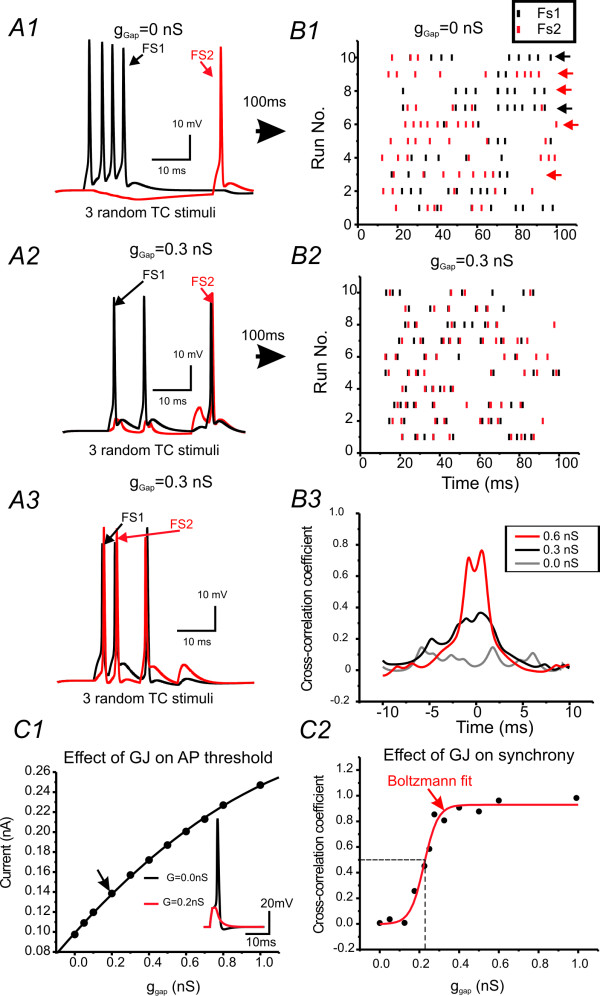
Roles of EPJPs in synchronizing 'whisking-like' TC responses in simulated networks. A) Membrane responses in a pair of FS cells induced by three TC inputs with variable latency to each cell. B1&2) Raster plot of a similar experiment as A1 showing the timing of spikes induced by asynchronous TC impulses in the two model FS cells without EPJP (B1) or with EPJP (0.3 nS, B2). Black and red arrows: FS cells 1 or 2 fire separately to the TC stimuli. B3) Cross-correlation analysis for evoked responses in the two model FS cells with different coupling strength (0-0.6 nS). C1) Effects of EPJP conductance on the spike initiation in model FS cells. C2) The relationship between EPJP strength and the cross-correlation coefficient was plotted. The curve is a best fit for the Boltzmann relation, CC/CCmax = 1 + exp [(g + g1/2)/K]}-1 where g1/2 = 0.22 ± 0.01 nS, R2 = 0.96, Chi2 = 0.007. CC: cross-correlation coefficient.